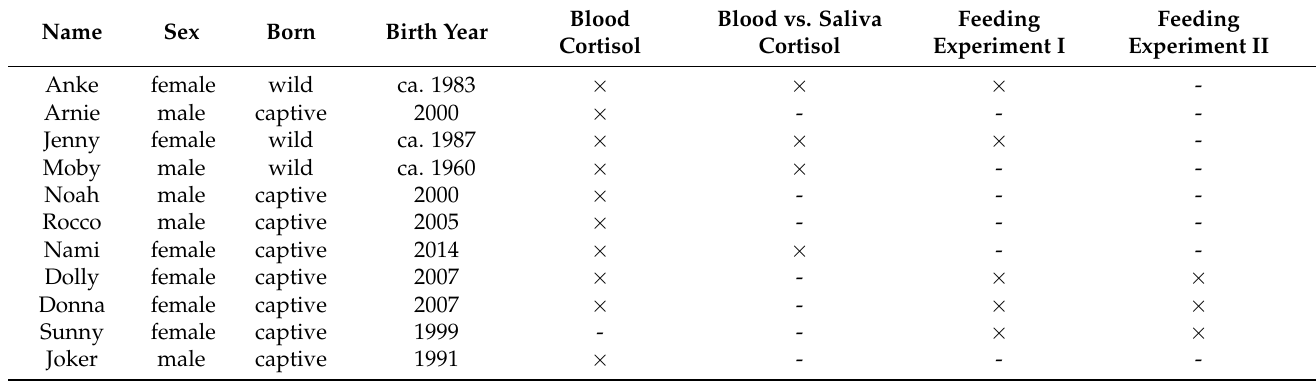
Table 1. Overview of the study animals and the tests and experiments they participated